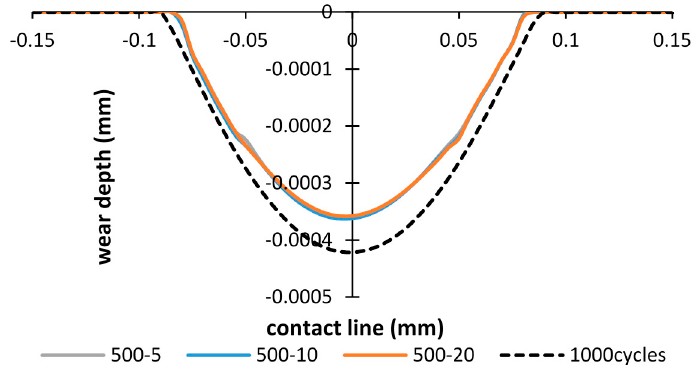
Figure 11. Wear scars after 1000 cycles: importing time= 500 cycles and layer thickness = 5 µ m, 10 µ m, 20 µ m.